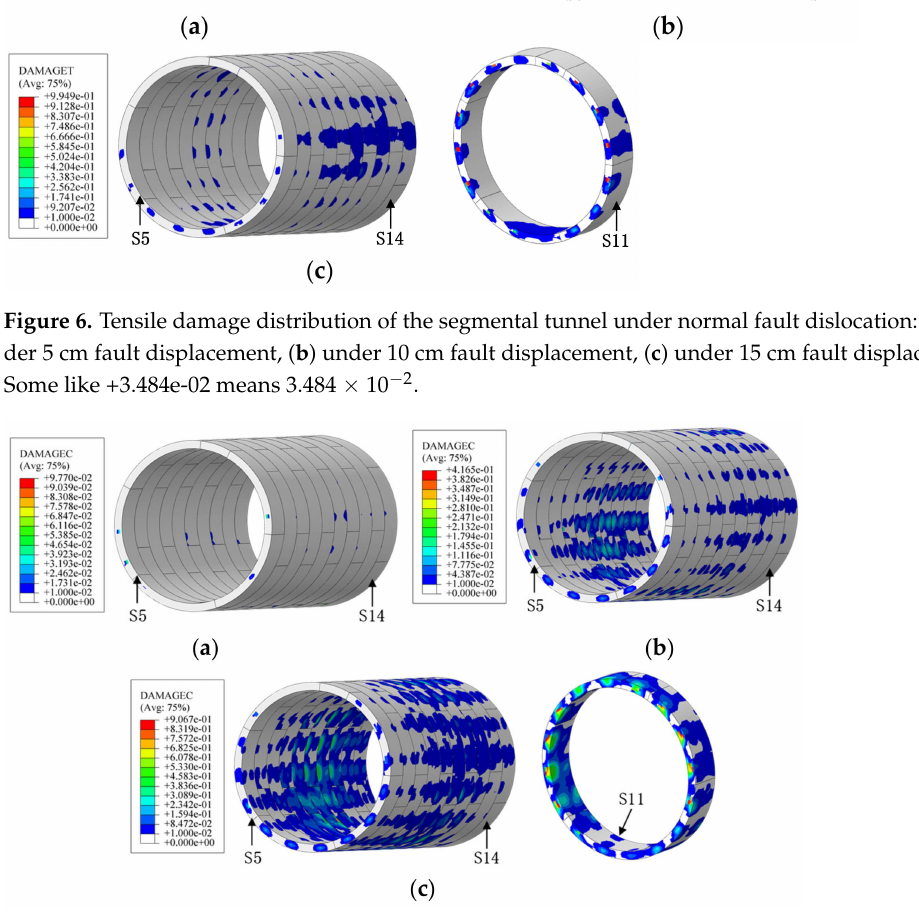
Figure 7. Compressive damage distribution of segmental lining under normal faulting: ( a ) under 5 cm fault displacement, ( b ) under 10 cm fault displacement, and ( c ) under 15 cm fault displacement. Some like +9.770e-02 means 9.770 × 10 − 2